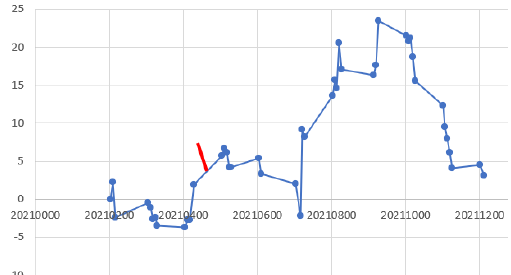
Figure 10. Surface displacement in mm, where there is the collapsed building, the redline indicates the date of collapsing.